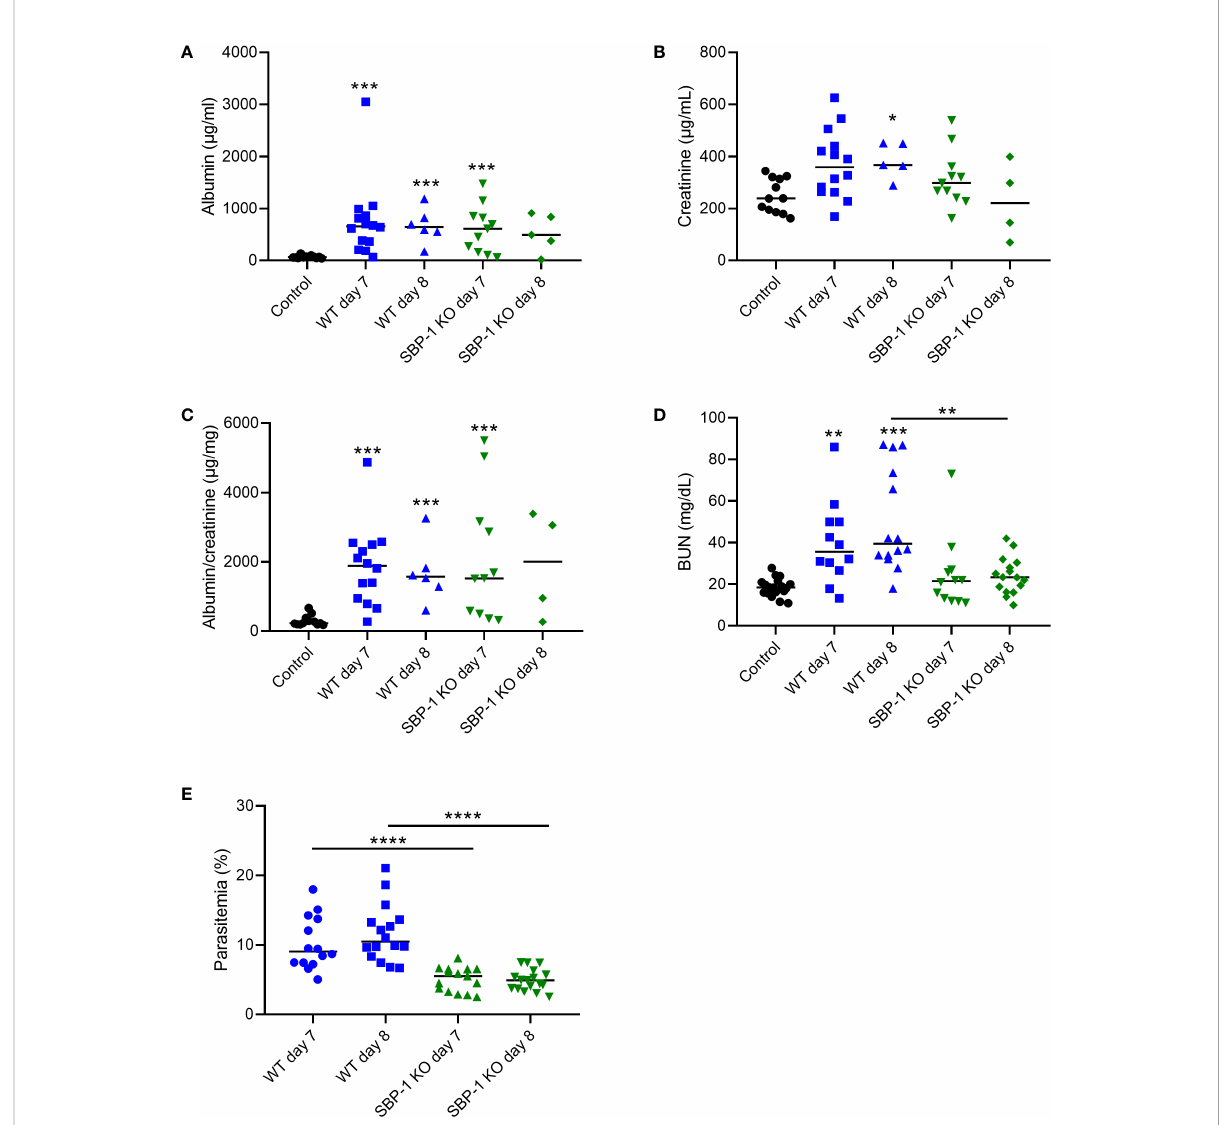
FIGURE 4 Similar proteinuria in WT and SBP-1 KO infected mice. C57BL/6 mice were infected with WT and SBP-1 KO Pb NK65 parasites. (A – C) Albumin, creatinine and albumin/creatinine ratios were determined in urine samples. (D) BUN values were determined in blood collected via retro-orbital puncture or in plasma collected via heart puncture. (E) Peripheral parasitemia was determined on blood smears. Asterisks above data points indicate signi fi cant differences compared to control mice, asterisks above a horizontal line show signi fi cant differences between infected groups, *p < 0.05, **p < 0.01, ***p < 0.001, ****p < 0.0001. (A – C) Data of 4 experiments, Control: n = 12, WT d7-d8: n = 5-14, SBP-1 KO d7- d8: n = 4-11, (D, E) data of 8 experiments, Control: n = 18, WT d7-d8: n = 12-16, SBP-1 KO d7-d8: n = 12-17. Mann-Whitney U test with Holm- Bonferroni correction for multiple testing (number of tests = 6) was